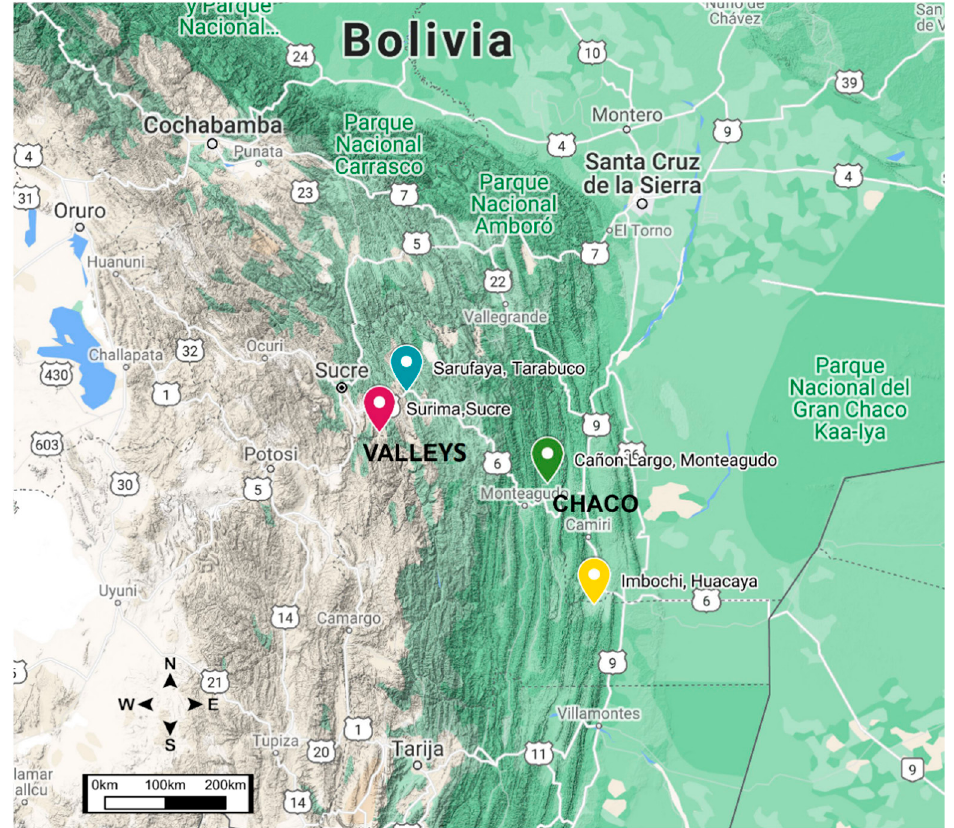
Figure 1. Coordinate information from the Military Institute of Geography of the four locations where Triatoma infestans populations were sampled in Chuquisaca.